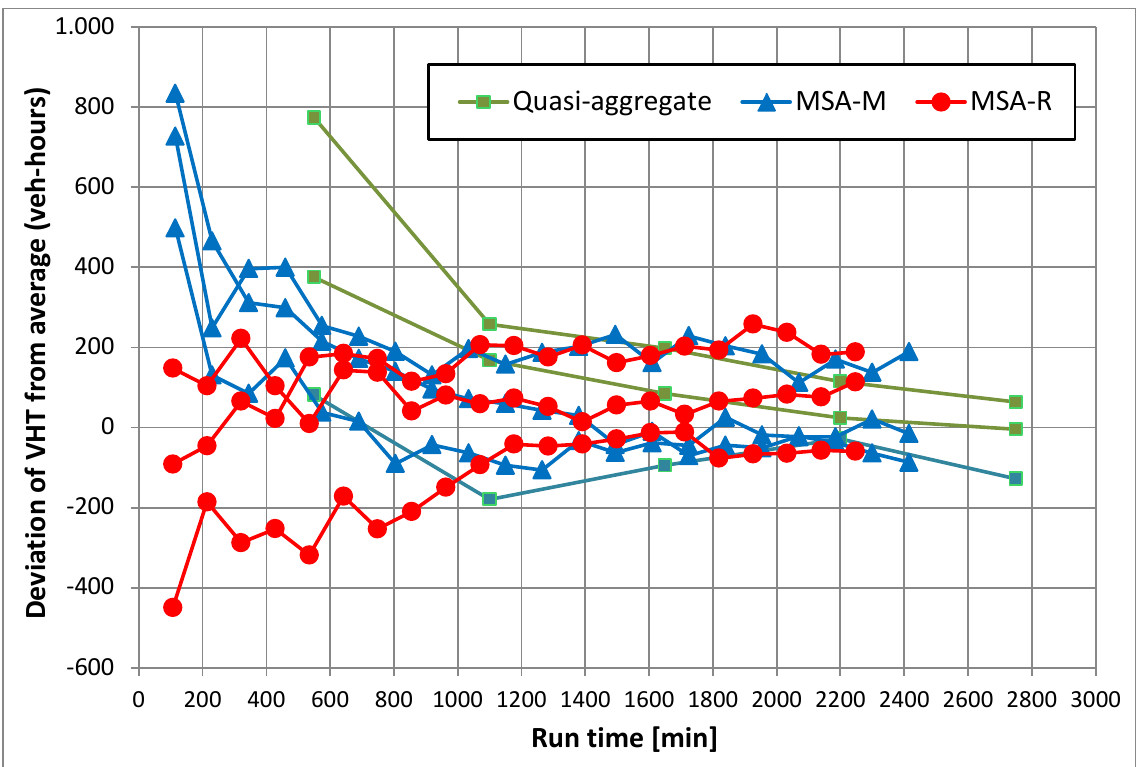
Figure 15. Convergence of averaging procedures as a function of run